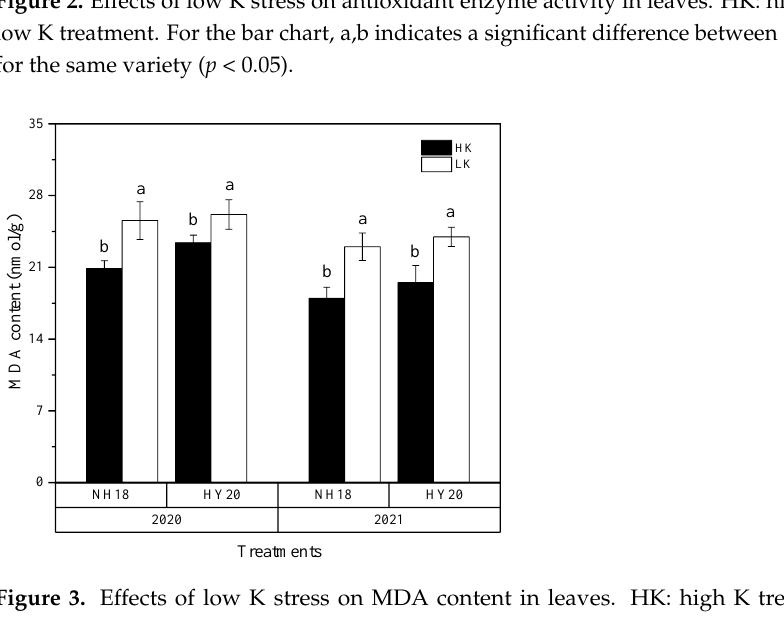
b Treatments Figure 4. Effects of low K stress on soluble protein content in leaves. HK: high K treatment; LK: low K treatment. For the bar chart, a,b indicates a significant difference between different treatments for the same variety( p < 0.05). 3.5. Effects of Low K Stress on Fluorescence Parameters Under low K stress, the partial red of HY20 and NH18 leaves was darker than that of leaves under HK, indicating that the F0 in these areas increases under low K stress (Figure 5A). The F0 of HY20 increased by 25.3% and 13.9% (Figure 5B), respectively, compared